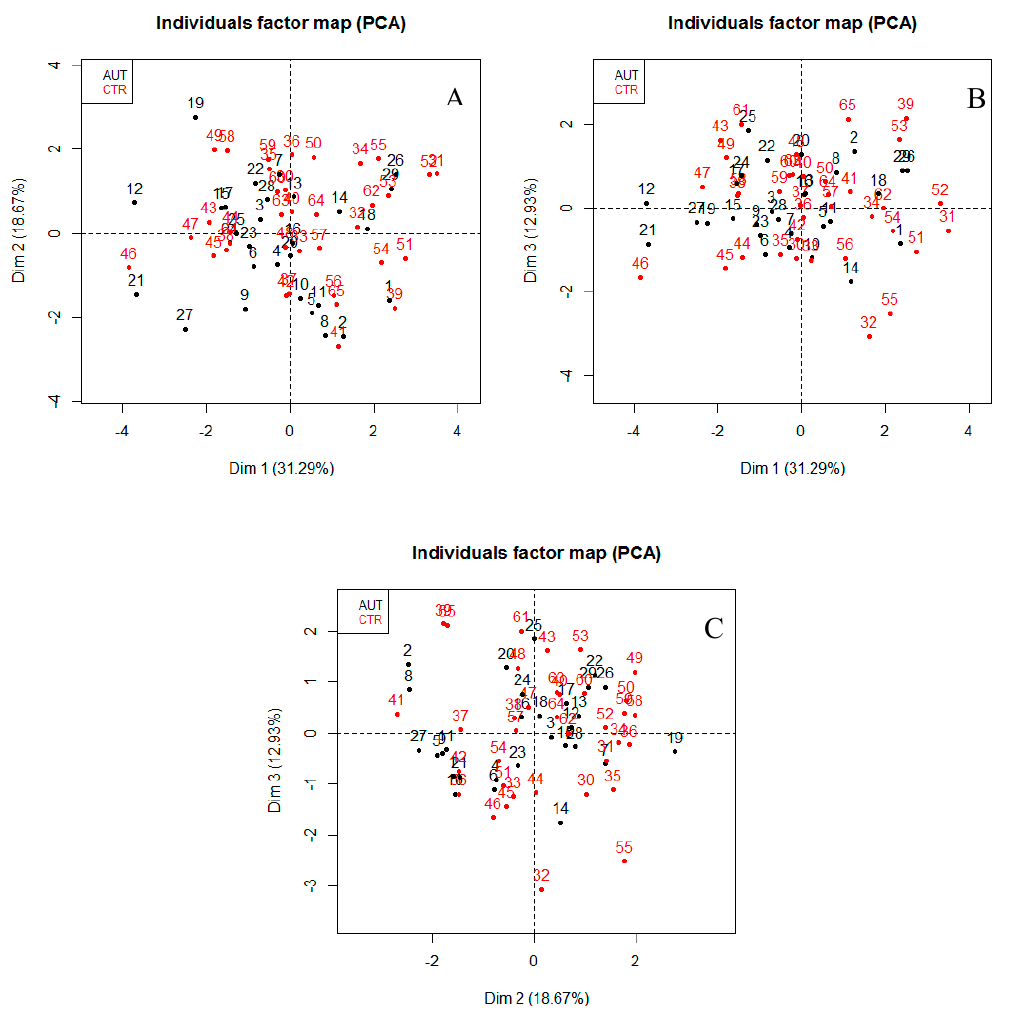
Figure 4. Projection onto the three projection plans PC1-PC2 ( A ); PC1-PC3 ( B ); and PC2-PC3 ( C ) of the dataset. The labels of the point are the identification numbers of the ASD children and CTR subjects.